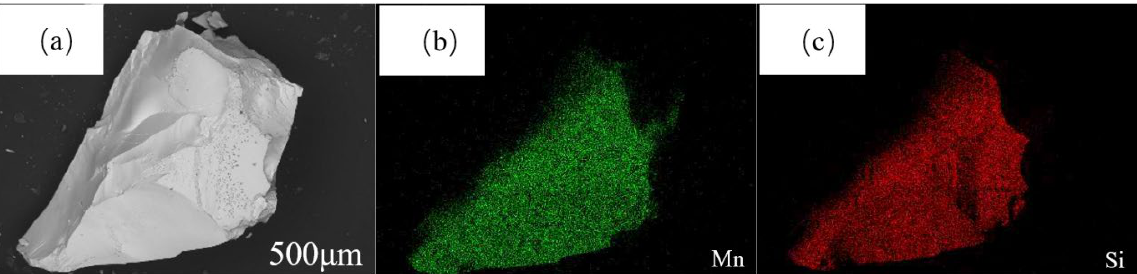
Figure 13. SEM-EDS image of the upper layer at 1873 K and 6 h: ( a ) SEM image; ( b ) Mn element distribution; ( c ) Si element distribution.